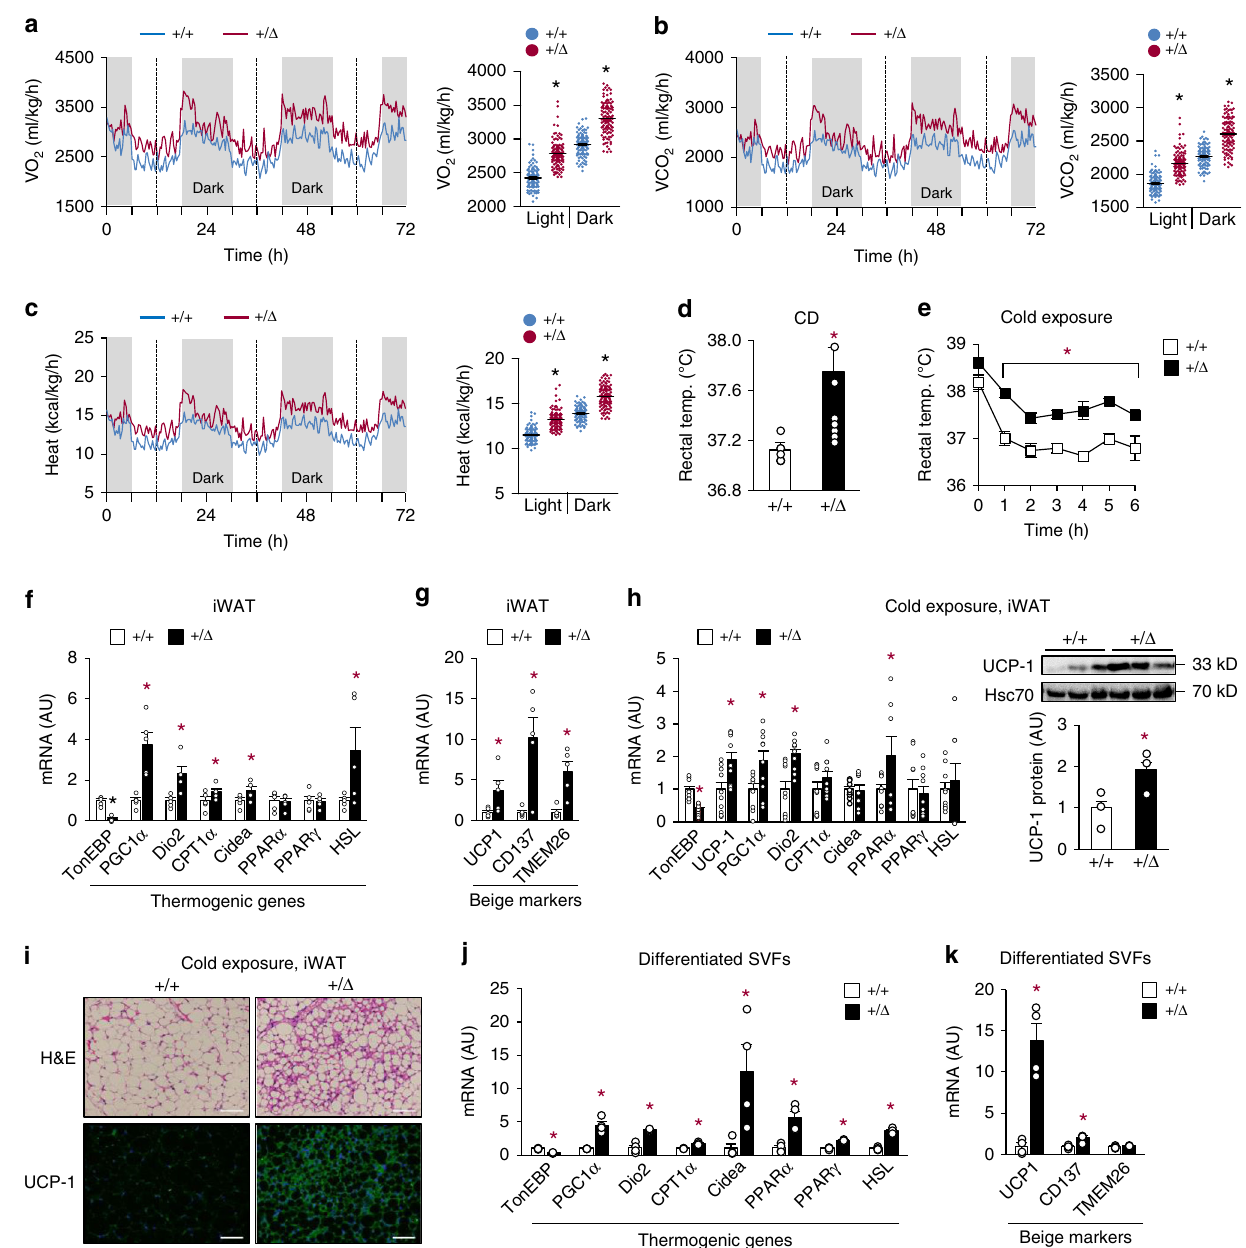
Fig. 2 TonEBP de fi ciency promotes energy expenditure and beiging of WAT. HFD-fed animals were analyzed by indirect calorimetry to obtain VO 2 ( a ), VCO 2 ( b ), and heat production ( c ) ( n = 4). Rectal temperature (temp.) measured in CD-fed animals at room temperature ( n = 8) ( d ) and after exposure to cold up to 6 h as indicated (4 °C) ( n = 6) ( e ). f , g mRNA abundance of thermogenic genes ( f ) and beiging marker genes ( g ) in iWAT of HFD-fed animals ( n = 5). h mRNA abundance of thermogenic genes (left, n = 10) and immunoblots of UCP-1 and Hsc70 (right, n = 3) in iWAT of CD-fed animals exposed to cold (4 °C). i Representative images of iWAT sections stained with H&E and UCP-1 antibody from CD-fed animals exposed to cold (4 °C). Scale bars, 100 μ m. j , k Thermogenic gene ( j ) and beige marker ( k ) mRNA abundance in beige adipocytes differentiated from the stromal vascular cells of iWAT ( n = 4). n represents number of biologically independent animals ( a – e ) or samples ( f – k ). a – h , j , k All data are presented as mean + s.e.m. AU arbitrary unit. The p -values are determined by unpaired t -test ( d , f – k ) or one-way ANOVA ( a – c , e ). * p < 0.05 vs. + / + . Source data are provided as a Source Data fi